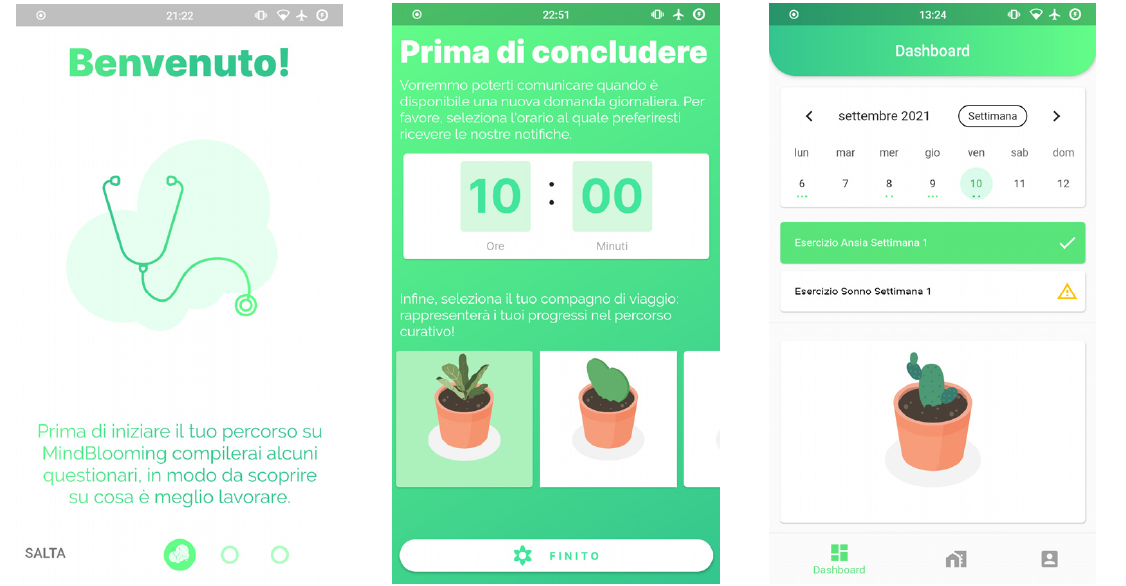
Figure 1. MindBlooming app user interface.